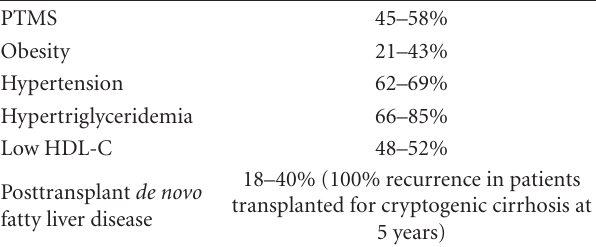
Table 2: Prevalence of Posttransplant Metabolic Syndrome (PTMS) and its